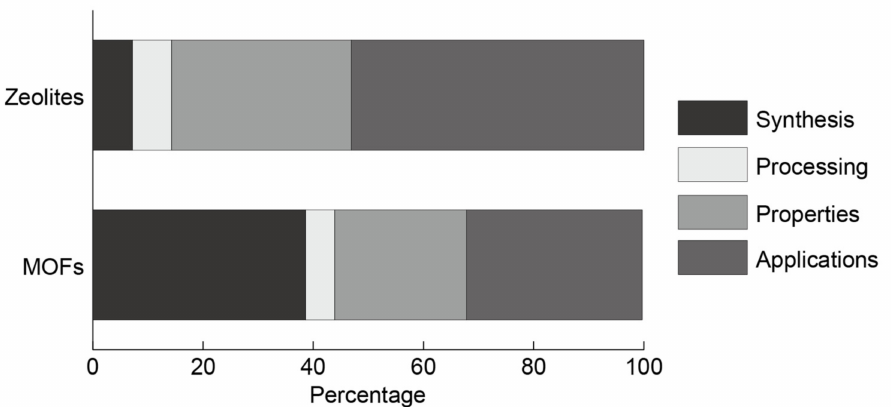
Figure 6. Ratios of publication numbers associated with four